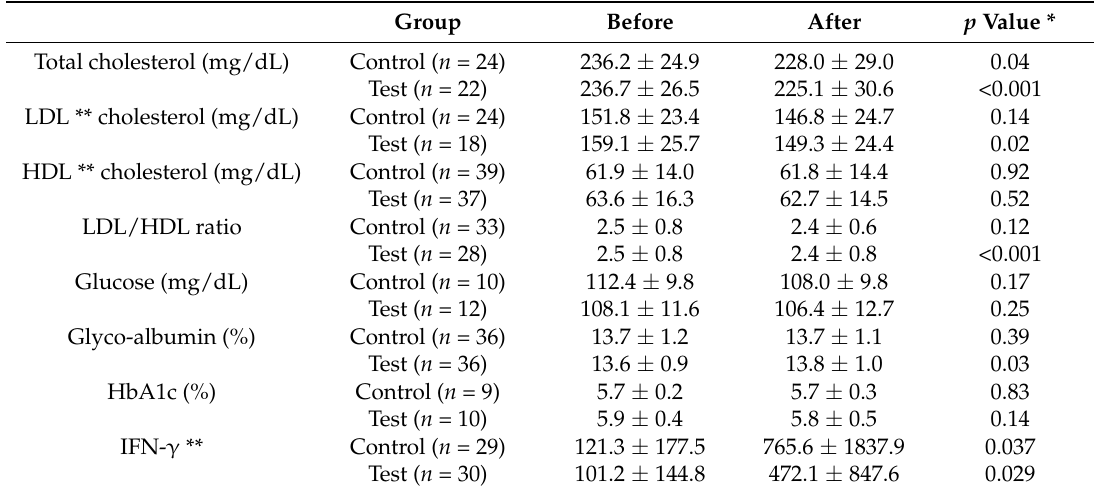
Table 3. Effect of yogurt in volunteers showing slightly elevated values for each parameter. Group